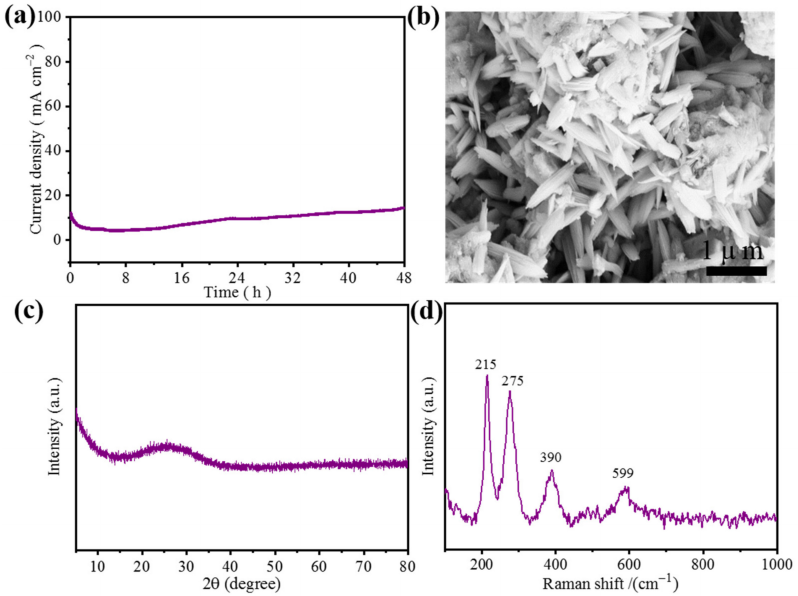
Figure 8. ( a ) The chronoamperometric curve for NH 4 -Fe 3 @KB-1, ( b ) SEM after stability test, ( c ) XRD after stability test, ( d ) Raman after stability